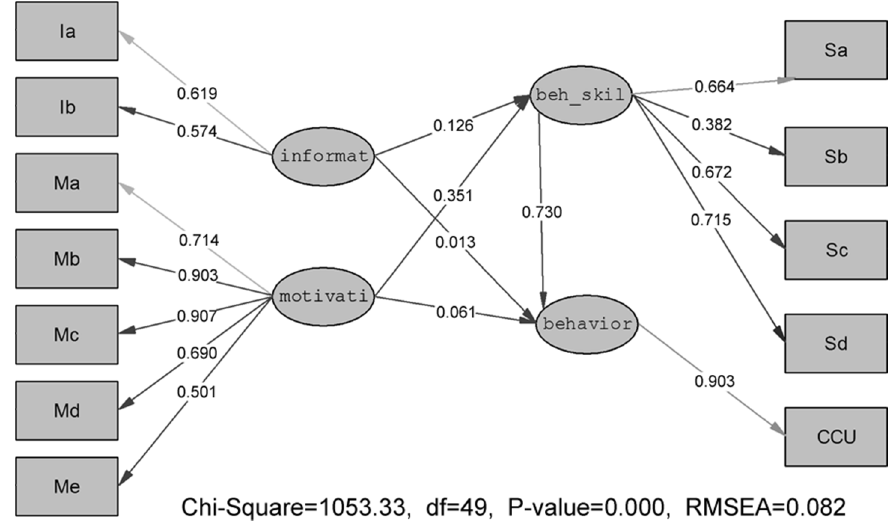
Figure 1. The initial predictive IMB model. Structural equation model depicts regression paths in the IMB model (N=3183). Large circles represent latent variables; rectangles represent single-item indicators; single-headed arrows represent regression coefficients. Regression coefficients are standardized.